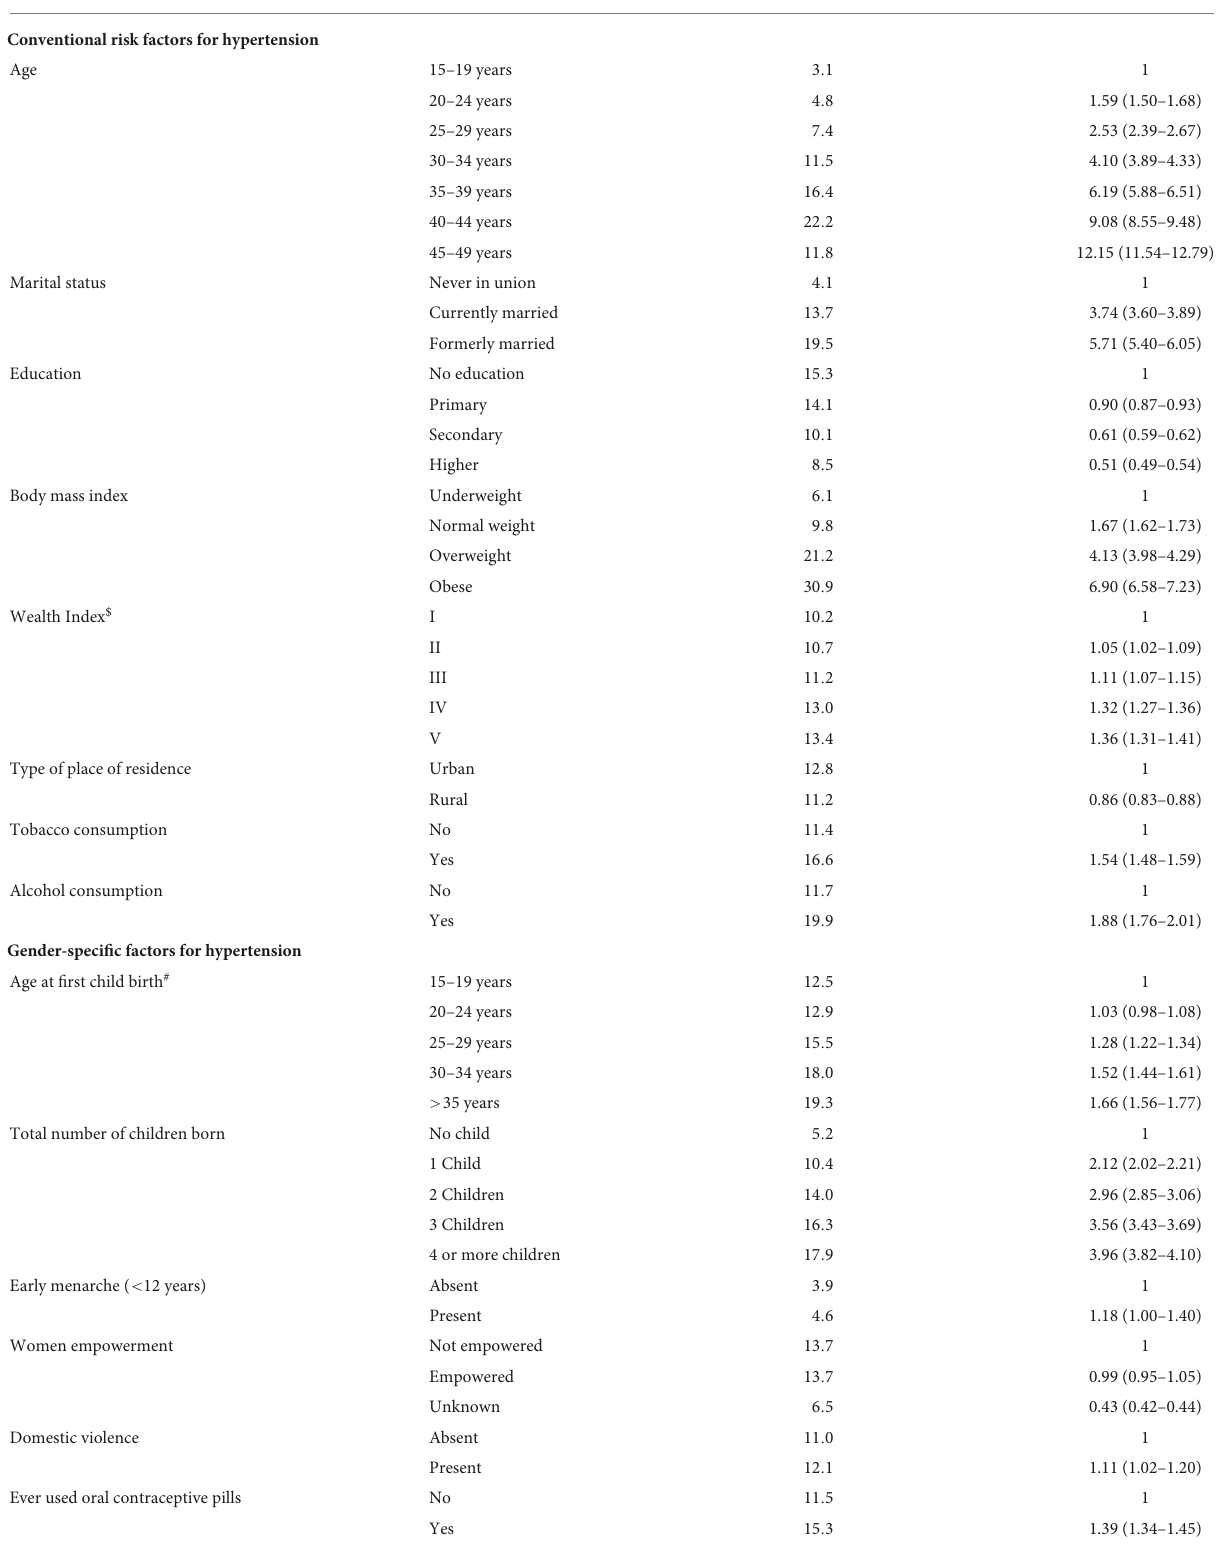
Prevalence (%) OR (95%